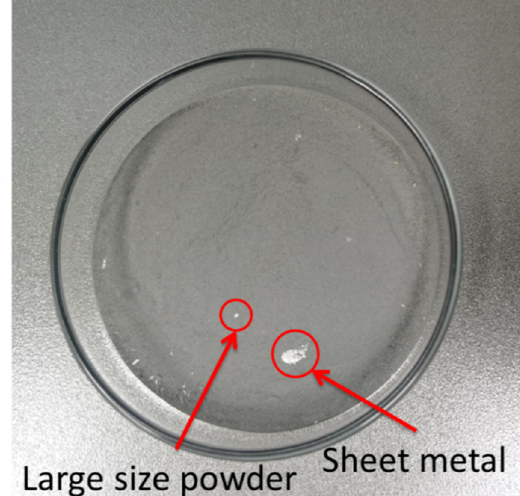
Figure 1. Original powder.